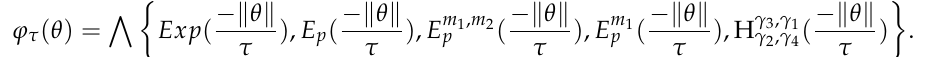
Table 1. Calculation of aggregation function according to special functions for different values